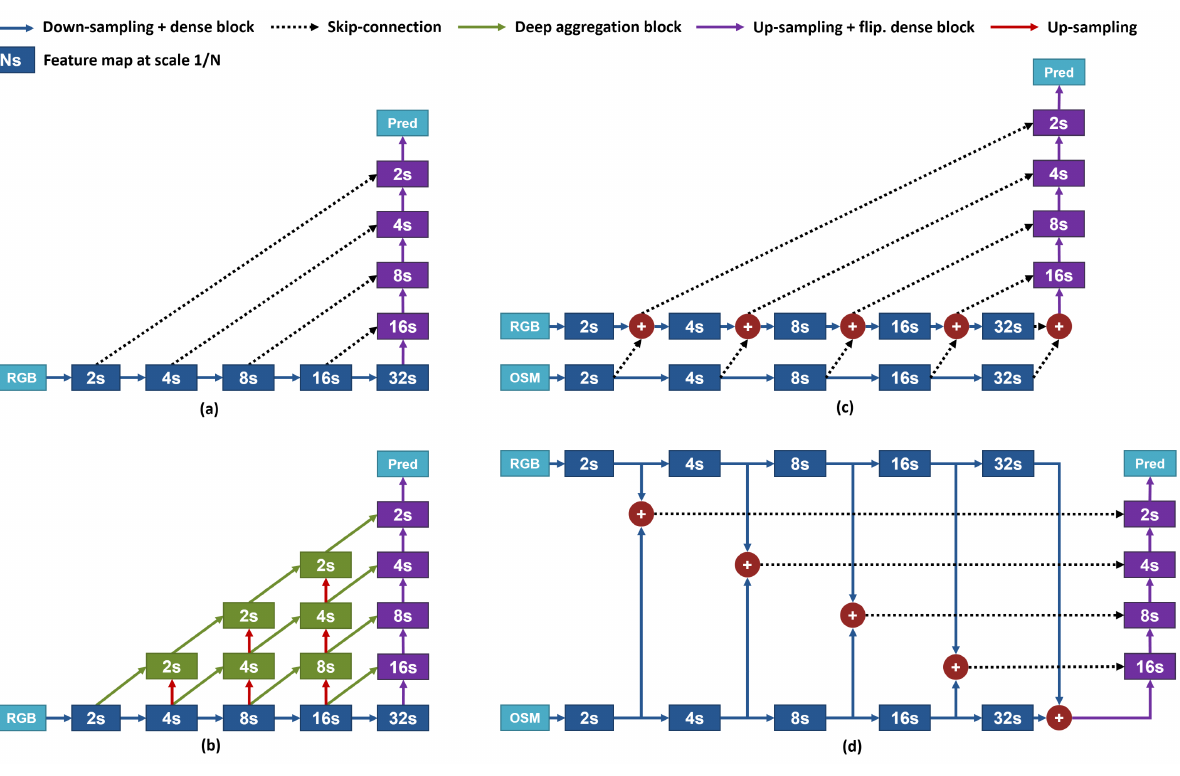
Figure 2. An overview of the different fully-convolutional neural network architectures used in our study: (a) Dense-U-Net, (b) DLA-Dense-U-Net, (c) Fuse-Dense-U-Net, (d) SkipFuse-Dense-U-Net. RGB, OSM and Pred. are described in Figure